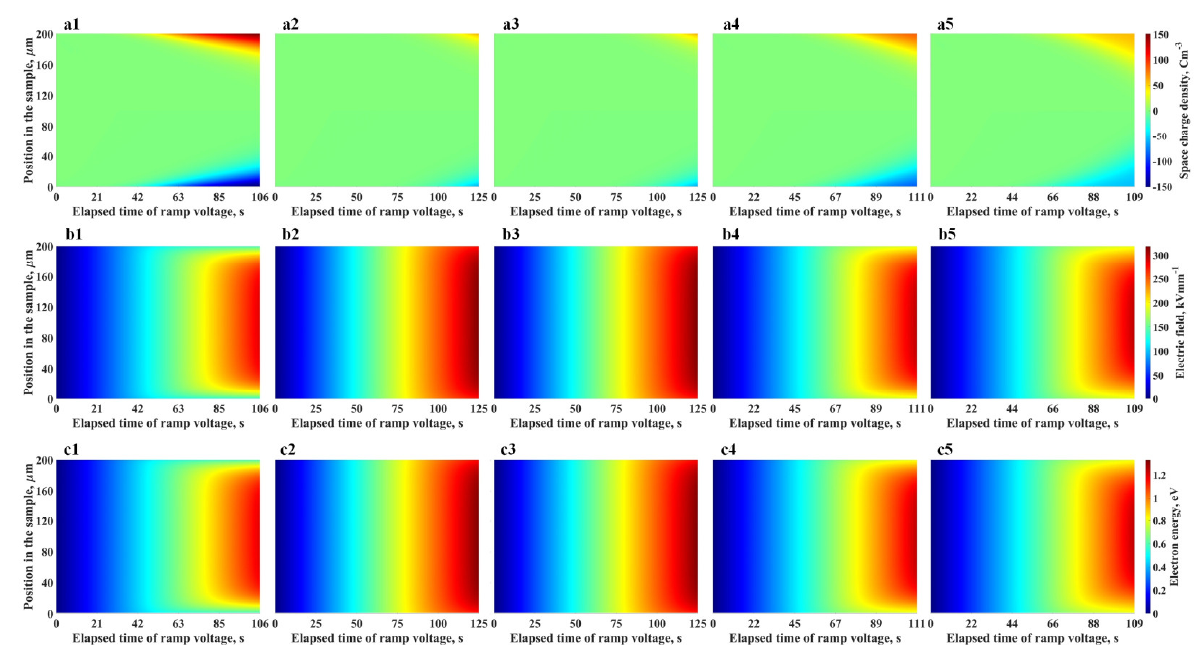
Figure 5. Distributions of space charges ( a1 – a5 ), electric fields ( b1 – b5 ), and electron energy gains ( c1 – c5 ) in pure LDPE and LDPE/Al 2 O 3 nanocomposites with nanofiller contents of 0.1 wt%, 0.5 wt%, 2.0 wt%, and 5.0 wt%.